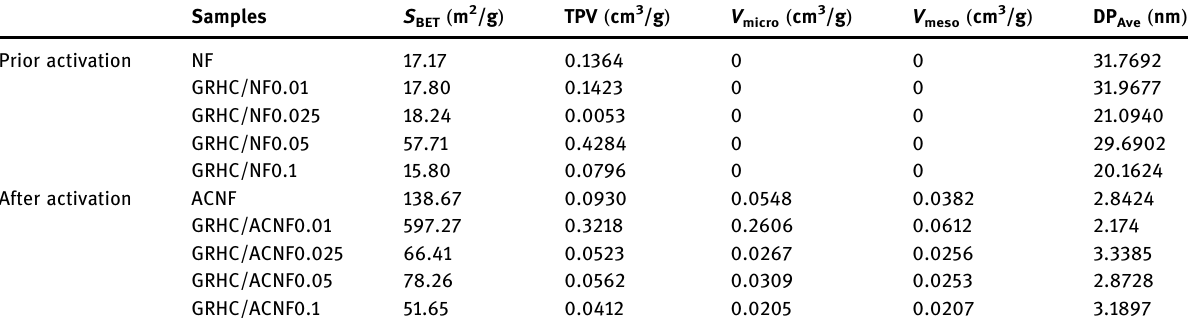
Table 2: Porous structure characteristics of pristine and composite ACNFs prior and after activation Samples